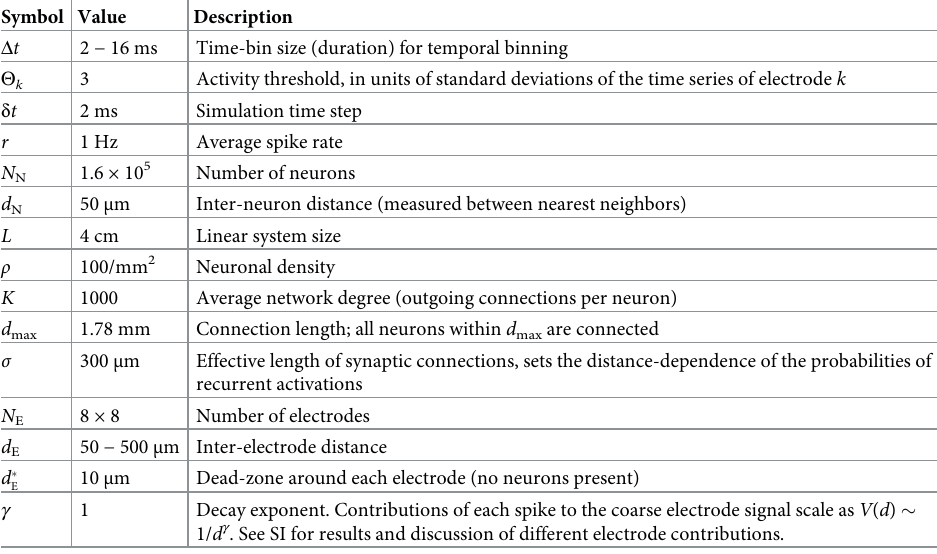
Table 3. Values and descriptions of the model